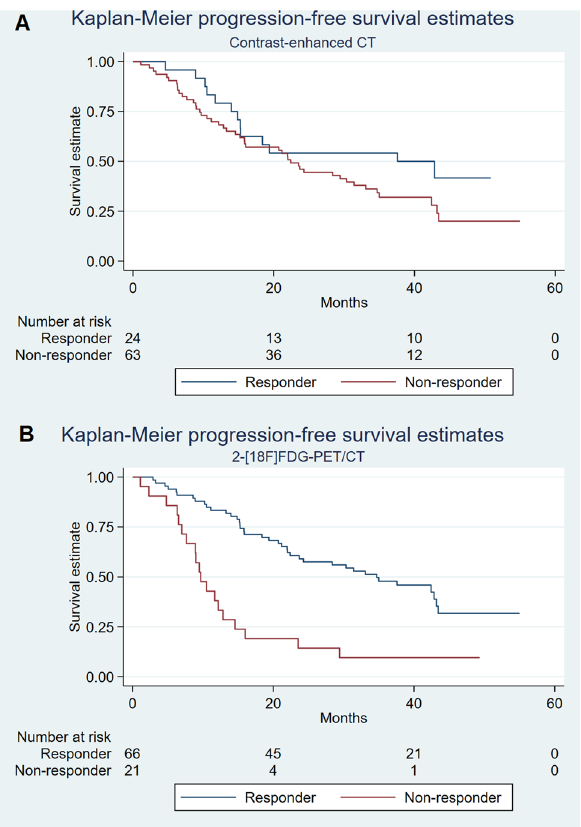
Figure 1. Kaplan–Meier plot of progression-free survival for responders and non-responders on ( A ) CE-CT and ( B ) 2-[ 18 F]FDG-PET/CT on the first follow-up